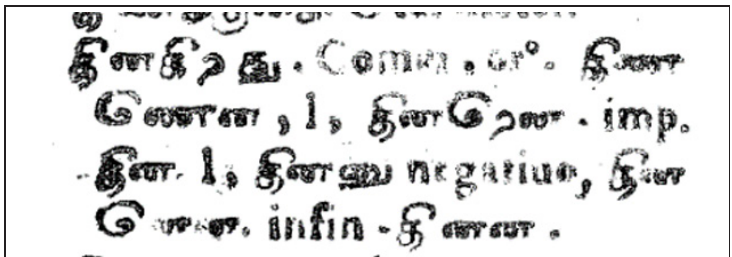
Figure 10: VTCSP Entry 361_L_d (ti